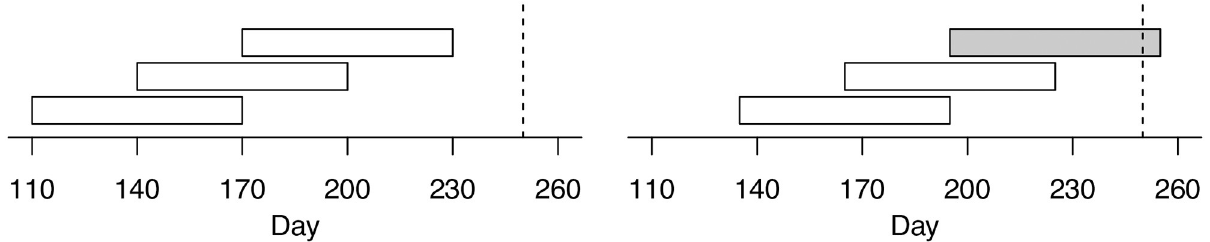
Fig 4. A schematic representation of the observation periods taken from the mid game phase, starting with day 110 and ending with day 250. Our modified moving window approach (advancing 30 days at a time) integrated all communication and support relationships that comprised a full 60-day